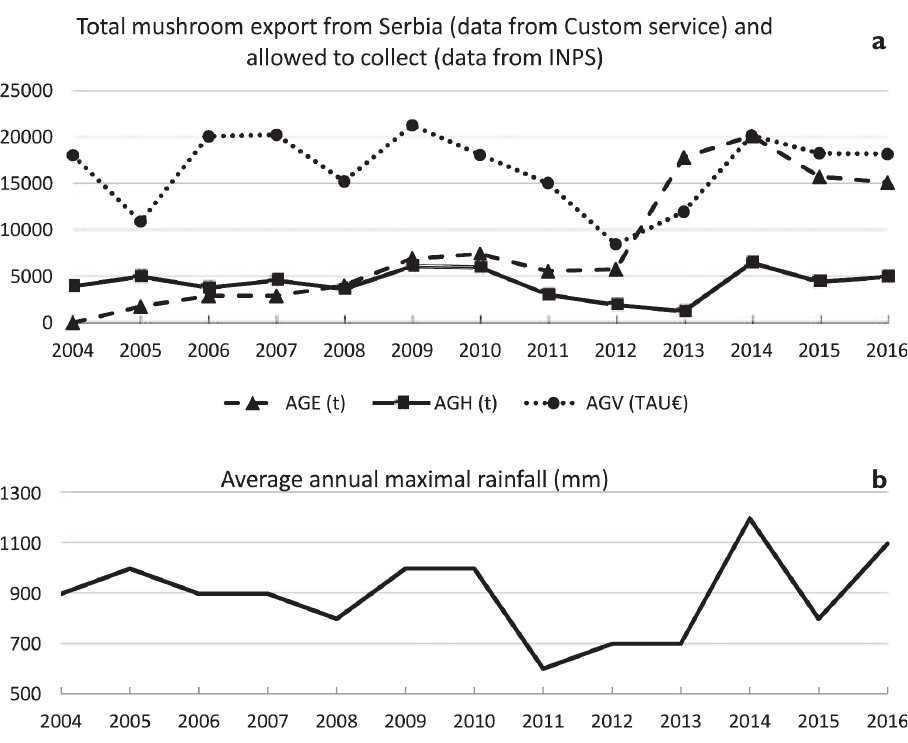
Figure 3. a Comparison between permitted and traded amounts of wild mushrooms in Serbia for the period 2004–2016. AGE of all mushroom species under control and their AGV as indicated on the export documents and provided by the Custom service of Serbia and AQ according to INCS b Average maximal rainfall rates for the investigated